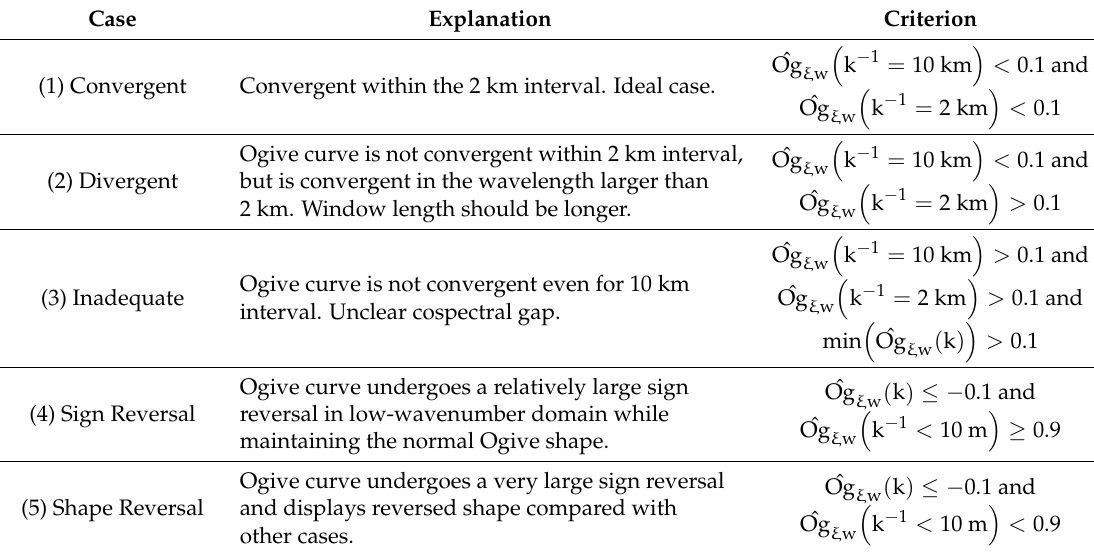
Table 2. Definition of five different cases for the behavior of Ogive curves of turbulent